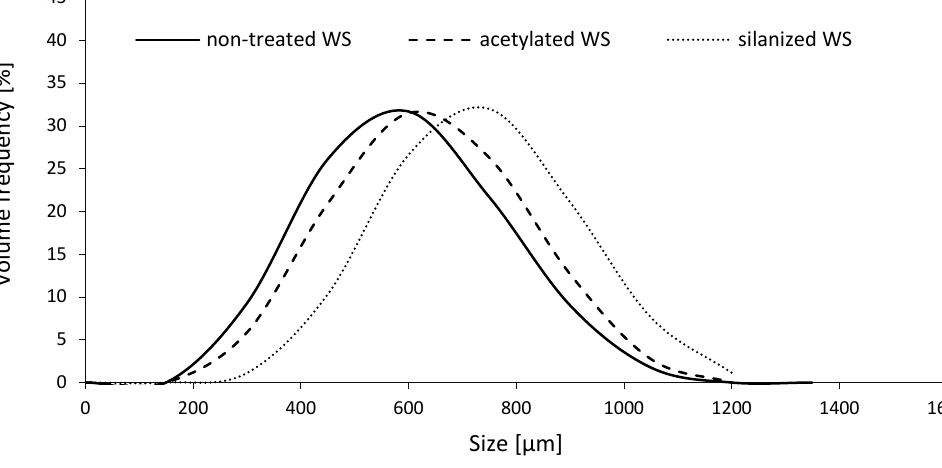
Figure 4. The results of particle size distribution.